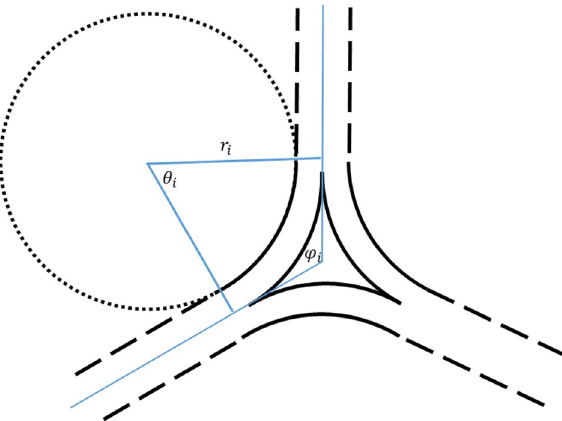
Figure 2. A sketch illustrating the structure of a three-way junction and the notations used in the